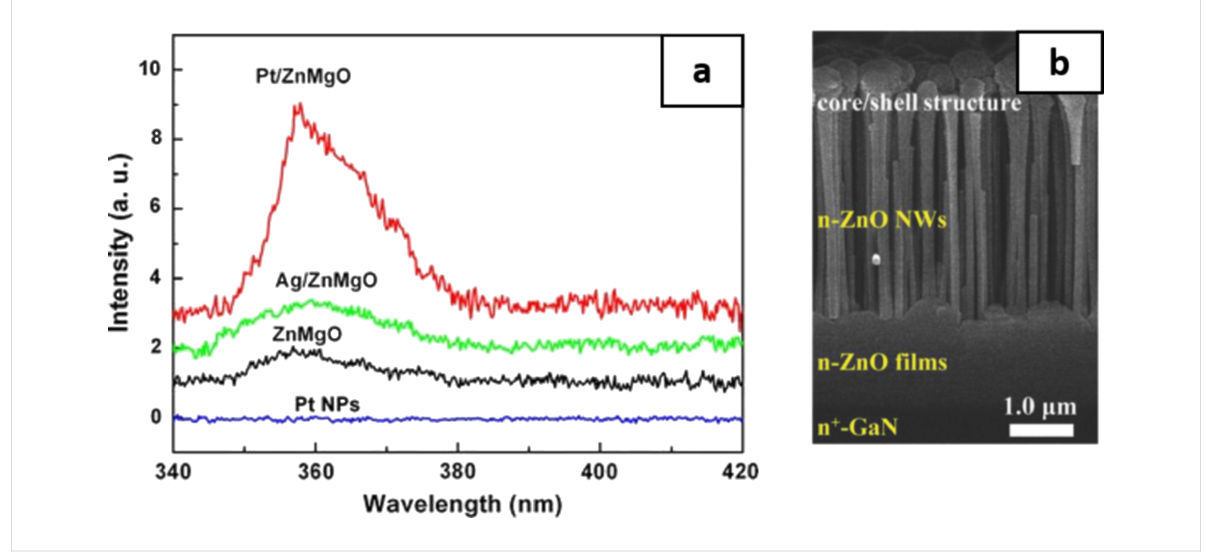
Figure 9: (a) Room temperature PL spectra of ZnMgO, Pt/ZnMgO, Ag/ZnMgO, and PtNP. A six-fold and a two-fold enhancement in the PL emission is observed for Pt/ZnMgO and Ag/ZnMgO, respectively. (b) Cross-sectional SEM image of the device architecture. Figure 9a was adapted from [104] (“Localized-Surface-Plasmon Enhanced the 357 nm Forward Emission from ZnMgO Films Capped by Pt Nanoparticles“, © 2009 J. B. You et al., dis- tributed under the terms of the Creative Commons Attribution 2.0 International License, https://creativecommons.org/licenses/by/2.0/). Figure 9b was adapted from [57], Z. Shi et al., “Localized Surface Plasmon Enhanced All-Inorganic Perovskite Quantum Dot Light-Emitting Diodes Based on Coaxial Core/Shell Heterojunction Architecture”, Adv. Funct. Mater., with permission from John Wiley and Sons. Copyright © 2018 WILEY-VCH Verlag GmbH & Co. KGaA, Weinheim. This content is not subject to CC BY